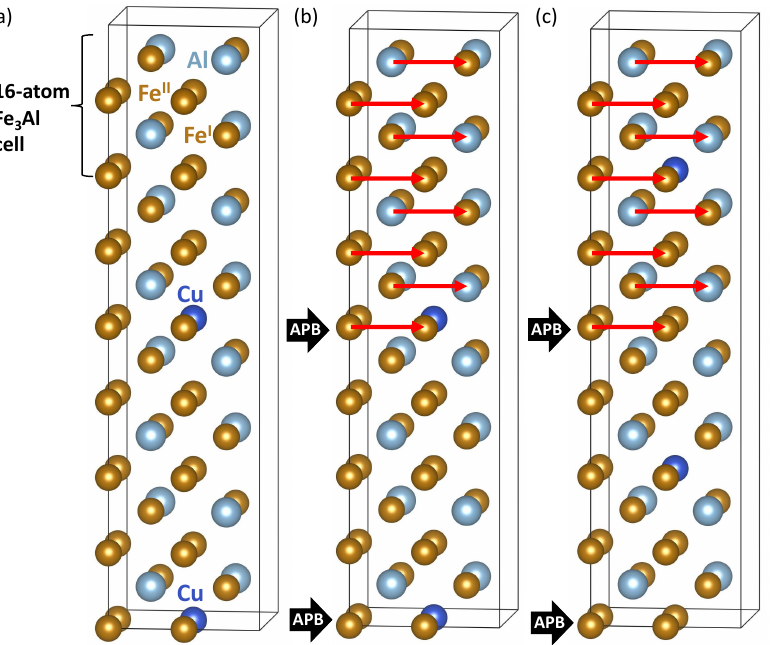
Figure 1. Supercells used in our study. Part ( a ) shows a 64-atom supercell as an 1 × 1 × 4 multiple of the 16-atom elementary cell of Fe 3 Al. Parts ( b , c ) visualize the studied types of antiphase boundaries (APBs) with Cu atoms located either directly at the APB interfaces ( b ) or away from them ( c ), respectively. The subfigures ( b , c ) include red vectors defining a (cid:104) 100 (cid:105) shift that is characteristic for the studied APBs and applied to the upper halves of the 64-atom